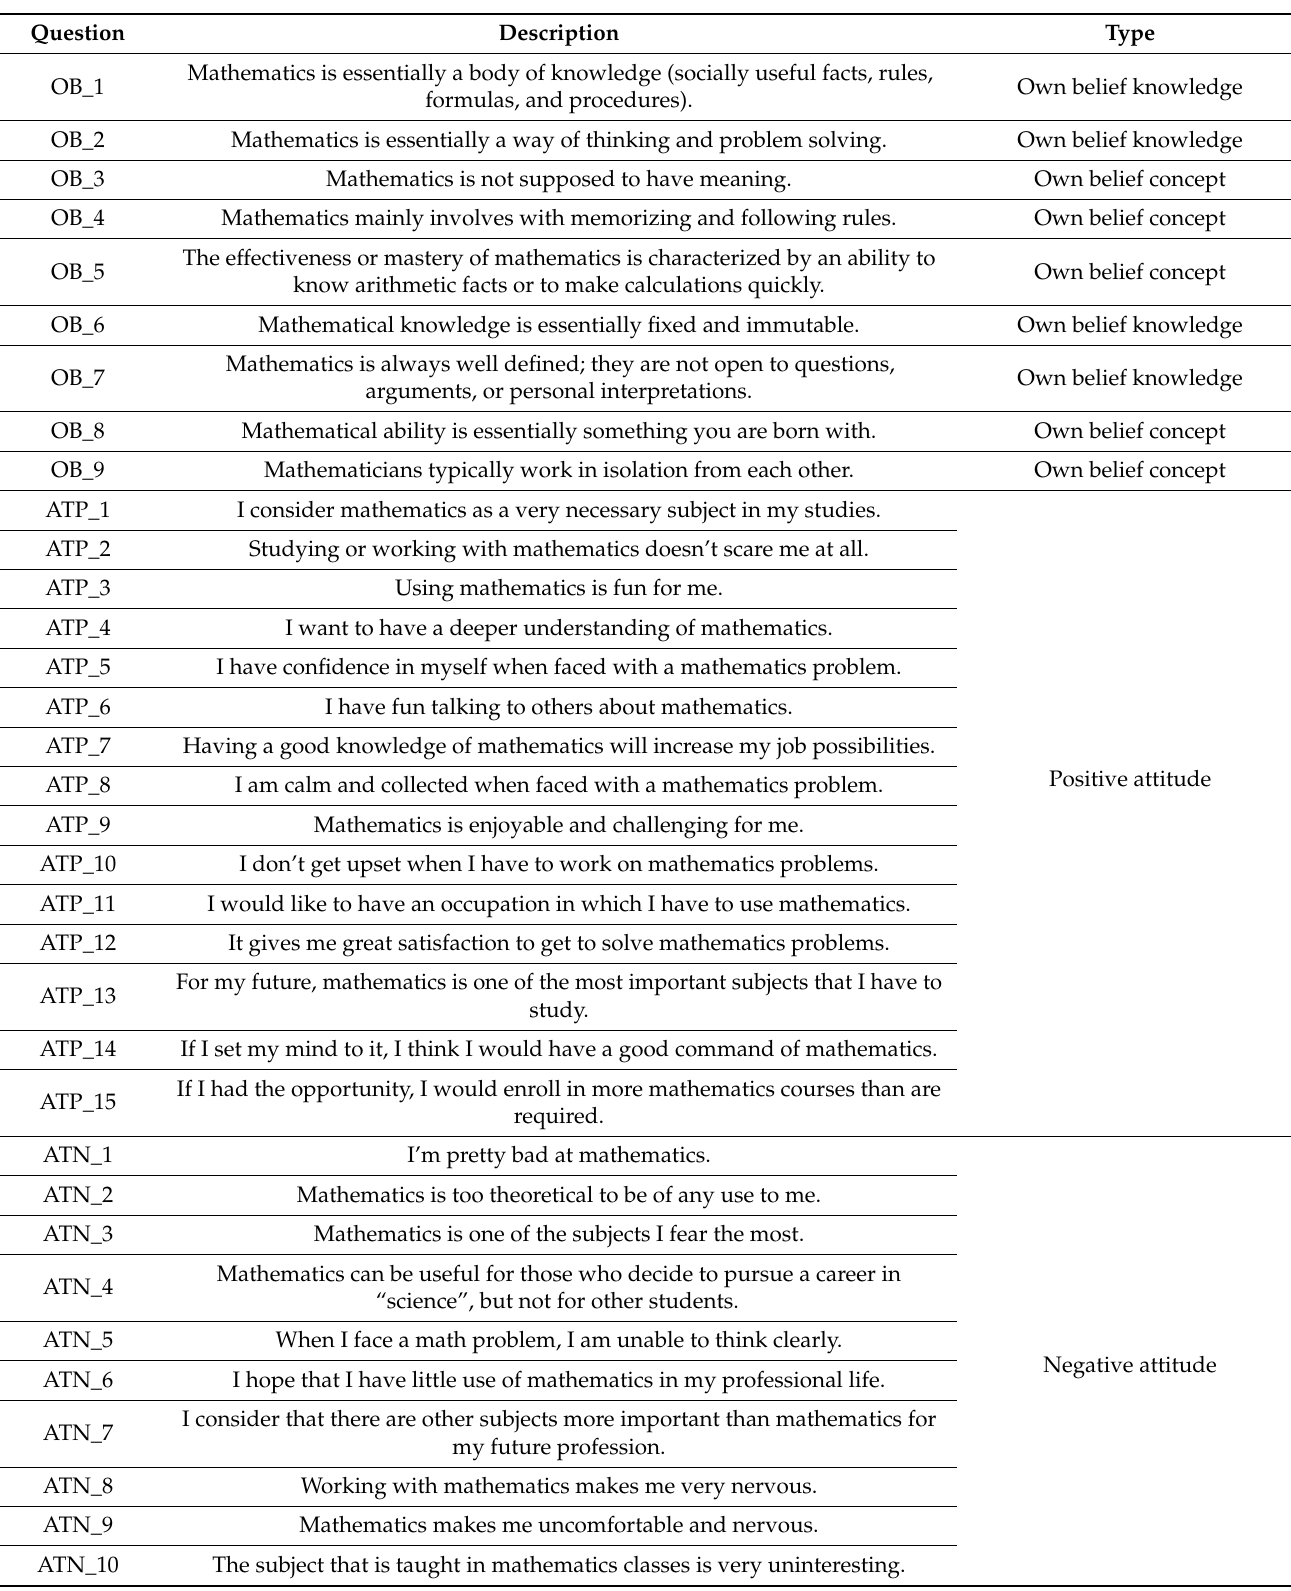
Table 3. Survey questionnaires for the attitude of pre-service teachers (PSTs) toward mathematics learning with the flipped-OCN